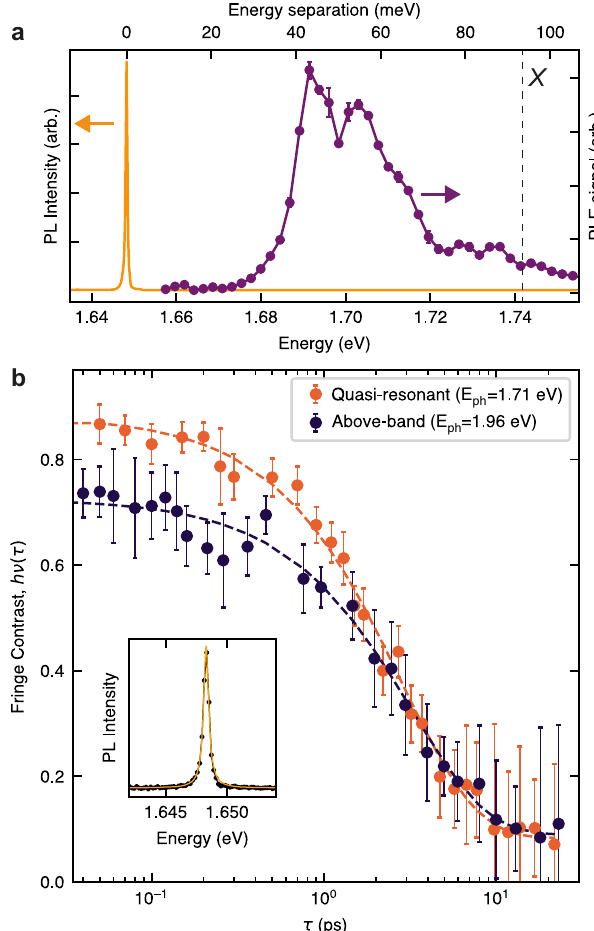
Fig. 4 Measurements of SPE coherence. a PL emission (yellow) and the PL excitation (PLE) spectra (purple) from a WSe 2 SPE. The PLE signal exhibits a series of con fi ned exciton peaks below the neutral exciton PL peak position ( X ). b Interference fringe contrast, ν ( τ ) for two different excitation laser wavelengths. The dependence for the above-band excitation (dark blue dots) is obtained at 1.96 eV (638 nm) and yields a coherence time of T = 2.83 ± 0.20 ( fi tting shown with a dashed line). The dependence for the 2 quasi-resonant excitation (orange dots) is obtained with a laser tuned to 1.71 eV (725 nm), lower than the A-exciton in unstrained monolayer WSe 2 , yielding a coherence time of T 2 = 3.12 ± 0.40. The error bars are calculated form the standard deviation of the fi t values. Inset: SPE PL spectrum under the quasi-resonant excitation (black dots) fi tted with a single Lorentzian peak (yellow solid line) with a linewidth of 450 μ eV, corresponding to a coherence time of T 2 = 2.9 ps, in close agreement with the values obtained from the interferometric